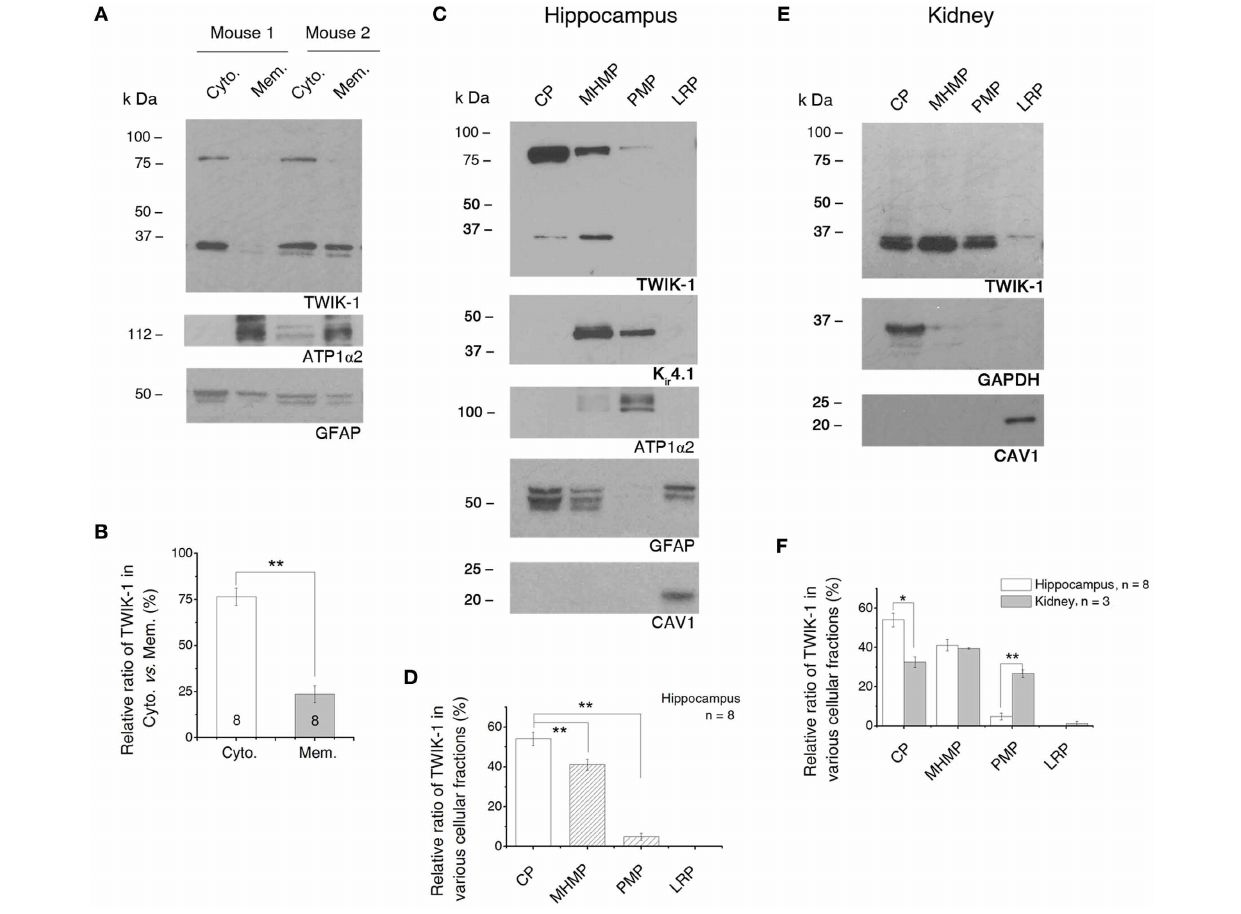
relative less in MHMP and very low in PMP fraction. K ir 4.1 (42kDa), another glial specific K + channel, was detected from both of the MHMP and PMP as anticipated. (D) Quantitation of TWIK-1 subcellular location in the four subcellular regions noted above ( n = 8). (E) A representative blot with the second fractionation method in (C) from kidney proteins. GAPDH and CAV1 were used as cytoplasm and lipid raft markers, respectively. The amount of TWIK-1 channels in PMP fraction was significantly higher in kidney than that of the hippocampus. (F) Comparison of the subcellular location of TWIK-1 between hippocampus ( n = 8) and kidney ( n = 3). The blots shown in (A) , (C) and (E) were all first incubated with anti-TWIK-1 antibody and then re-probed with the rest of primary antibodies sequentially after the original membranes were stripped with stripping buffer. ∗ p < 0 . 05, ∗∗ p < 0 .